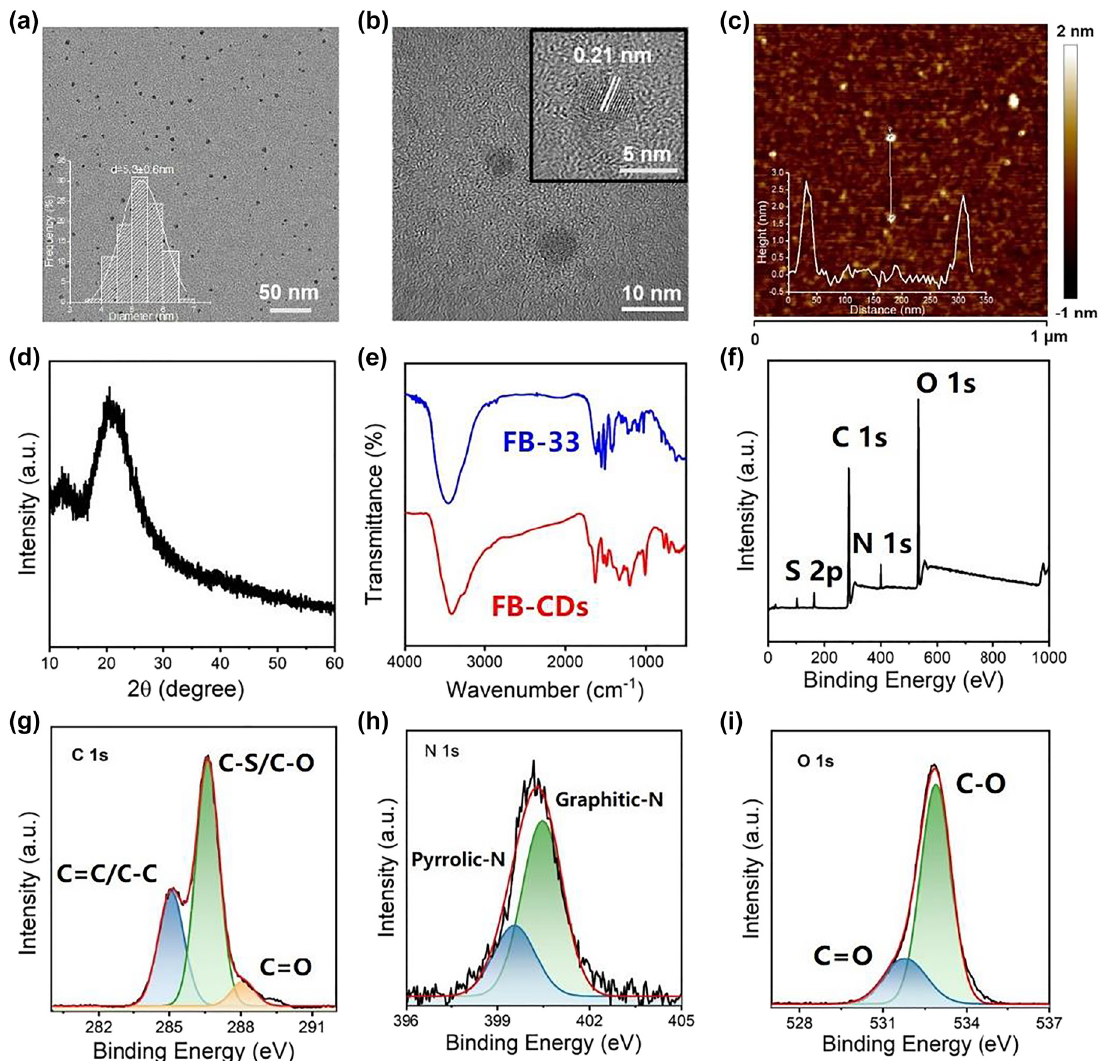
Figure 1: Characterization of FB-CDs. (a) and (b) TEM images of FB-CDs at different magnifications (Insets: (a) Particle size distribution and (b) the high-resolution TEM image of FB-CDs). (c) AFM image of FB-CDs, the inset showed the height profile along the line. (d) XRD pattern of FB-CDs. (e) FT-IR spectra of FB-CDs and FB-33, respectively. XPS analysis of FB-CDs: (f) survey scan, (g) C 1s, (h) N 1s, and (i) O 1s